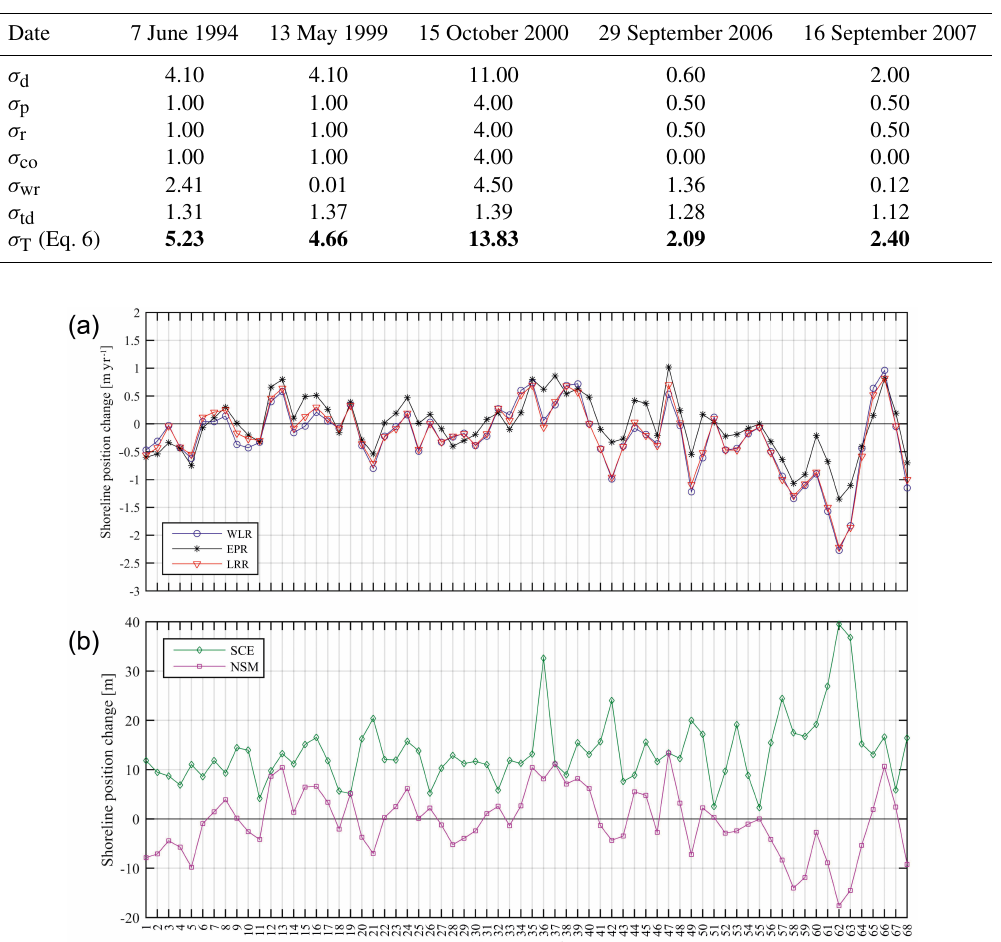
Figure 6. (a) Comparison among the change rate of the shoreline position at each transect during the studied period, expressed by end point rate (EPR), linear regression rate (LRR), and weighted linear regression rate (WLR). (b) Comparison between the net shoreline movement (NSM) and the shoreline envelope of changes (SCE) during the studied